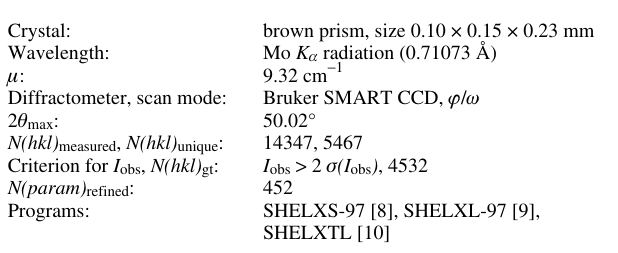
Table 1. Data collection and